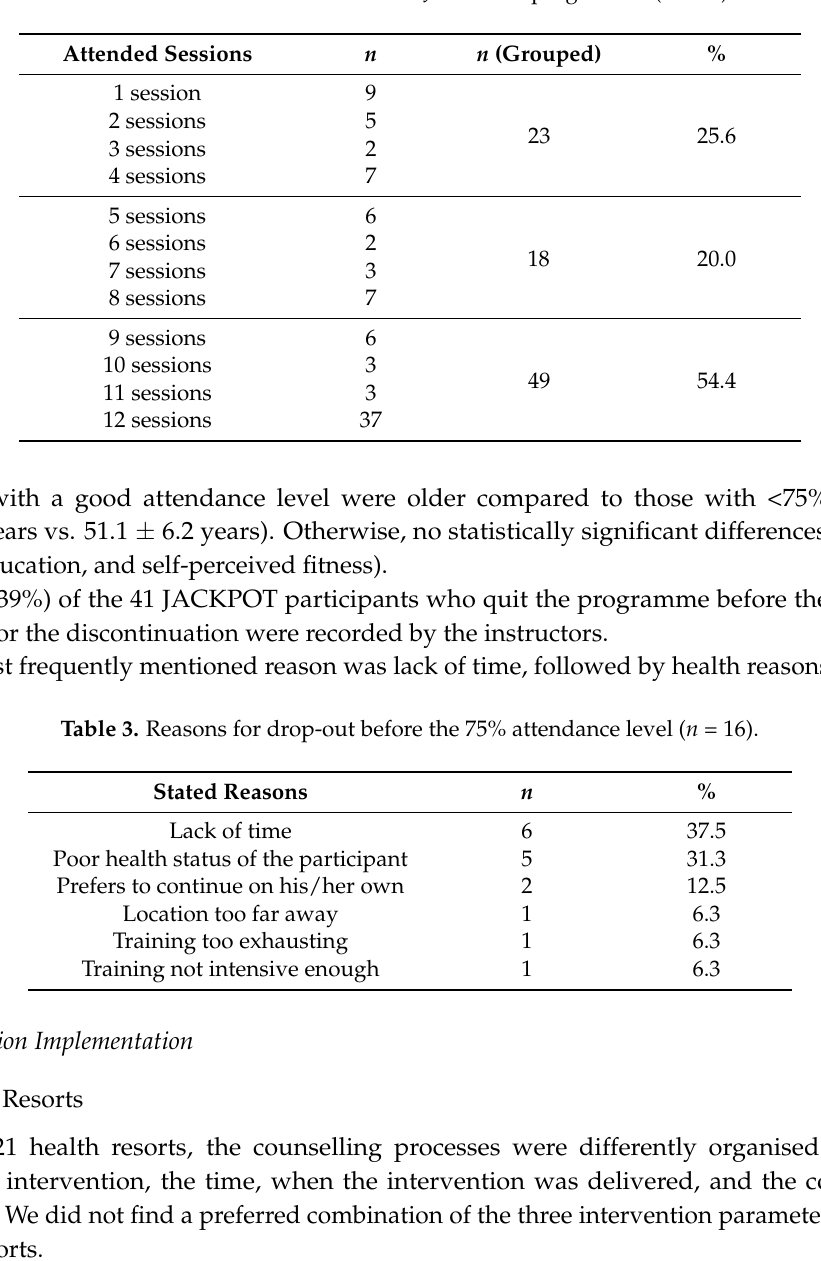
Table 2. Attendance levels for the JACKPOT programme ( n = 90).